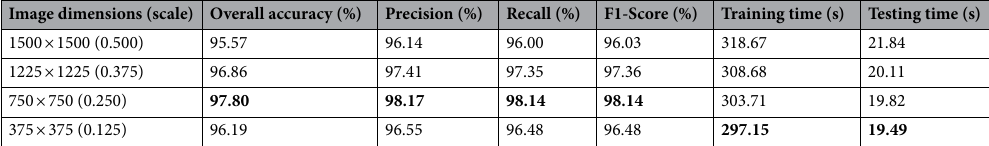
Table 4. Performance metrics for static signs at 500 bags. Significant values are in